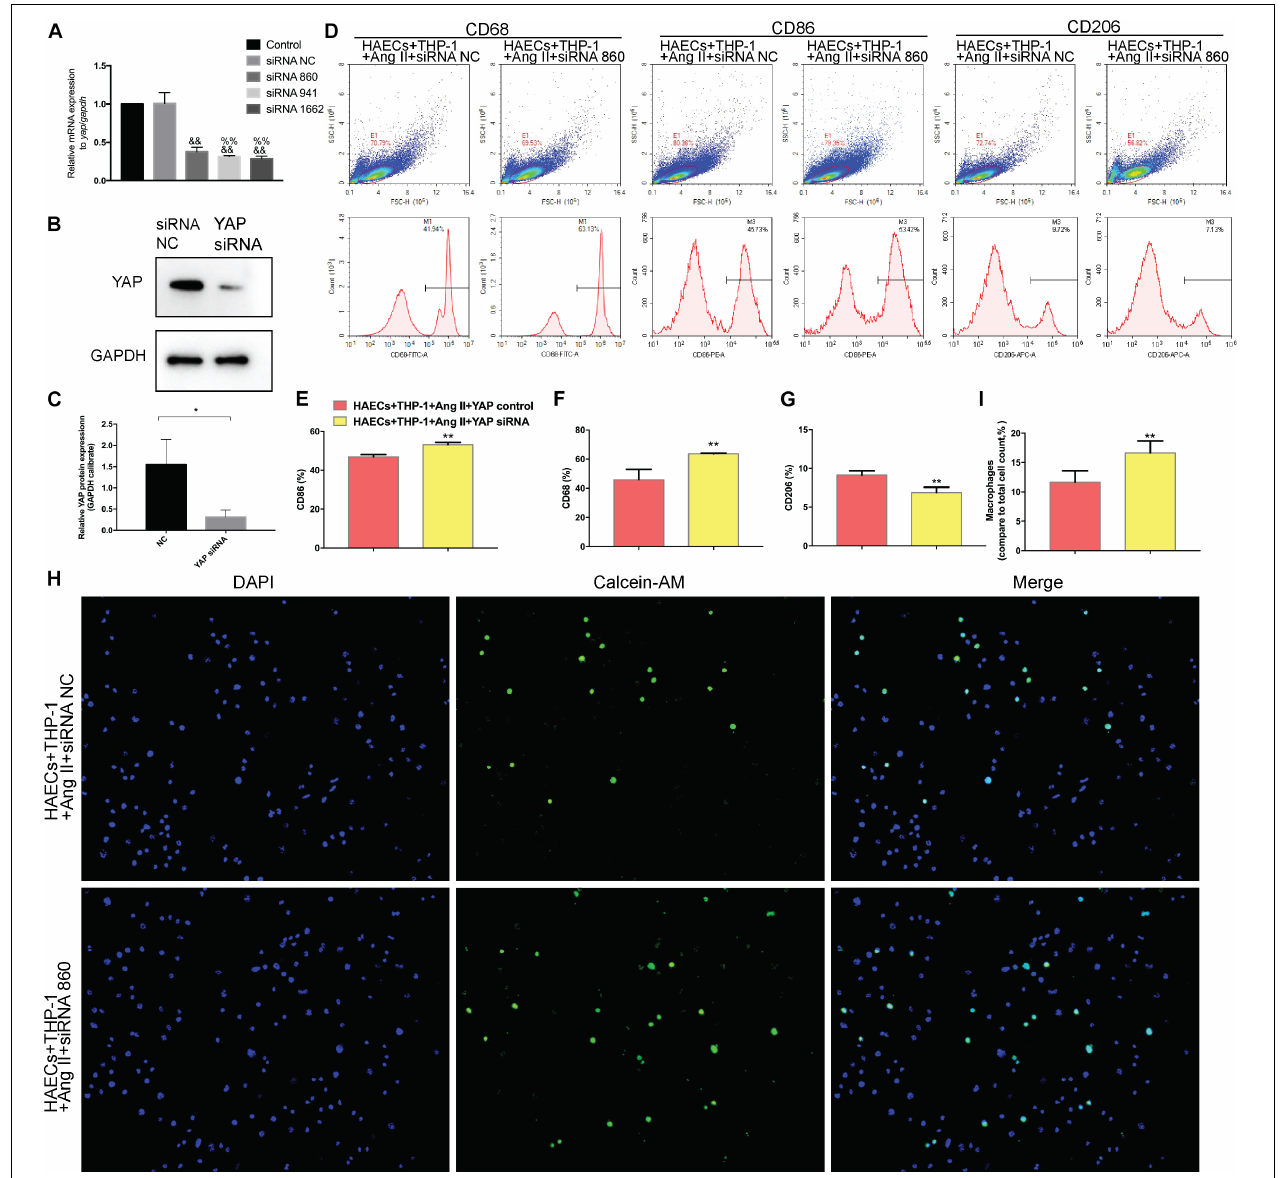
FIGURE 6 | Transfecting macrophages with a YAP siRNA further enhanced Ang II–induced macrophage M1 polarization and adhesion. (A) YAP siRNA efficiencies ( n = 3, mean and S.D., t -test, && P < 0.05 compared with siRNA NC; %% P < 0.05 compared with siRNA 860); (B,C) Western Blot of YAP after siRNA transfection * P < 0.05 compared with siRNA NC; (D) Flow cytometry analysis of CD68, CD86, and CD206 expression after 96 h co-culture in both groups. The data in the one-factor histogram represents the cells in the red circle in the upper scatter plot. HAECs + THP-1 + Ang II (1 µ M, 24 h) + siRNA NC group: CD68, 41.94%; CD86, 45.73%; CD206, 9.72%. HAECs + THP-1 + Ang II + YAP siRNA group: CD68, 63.13%; CD86, 53.42%; CD206, 7.13%; (E–G) The proportion of CD68 + , CD86 + , and CD206 + cells, respectively ( n = 3, mean and S.D., t -test, ** P < 0.05 compared with the HAECs + THP-1 + siRNA NC group); (H) Fluorescence staining of adherent macrophages after YAP siRNA transfection. All cells were labeled with DAPI (blue), and the number of adherent macrophages was significantly decreased after transfection with the AT1R siRNA; (I) The ratio between the number of macrophages and the total number of cells ( n = 3, mean and S.D., t -test, symbols are the same as in C,D,E